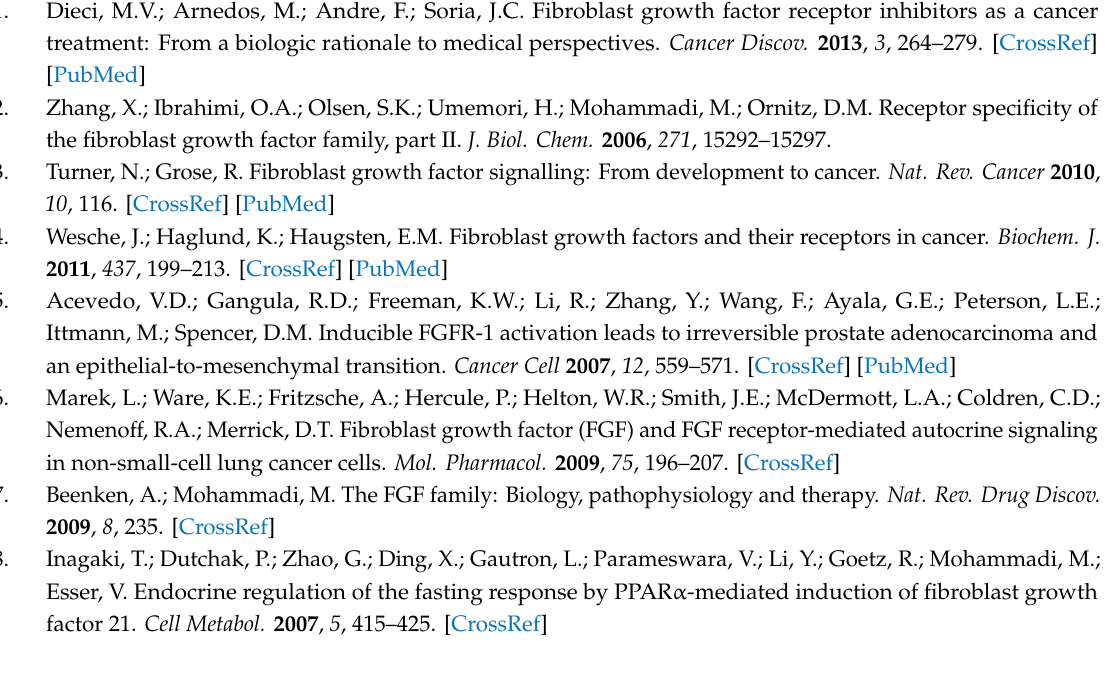
Table S2: Correlation analysis between serum FGF21 level and metabolic parameters in total participants with PTC (N = 127), Figure S1: Raw data of Western blot analysis of Figure 3, Figure S2: E ff ects of FGF21 on cell viability and migration of Nthy-ori3-1 cells, Figure S3: E ff ects of FGF21 on cell migration and invasion of PTC cells, Figure S4: Raw data of Western blot analysis of Figure 4, Figure S5: Raw data of Western blot analysis of Figure 5, Figure S6: Comparison of relative density of Western blot analysis of Figure